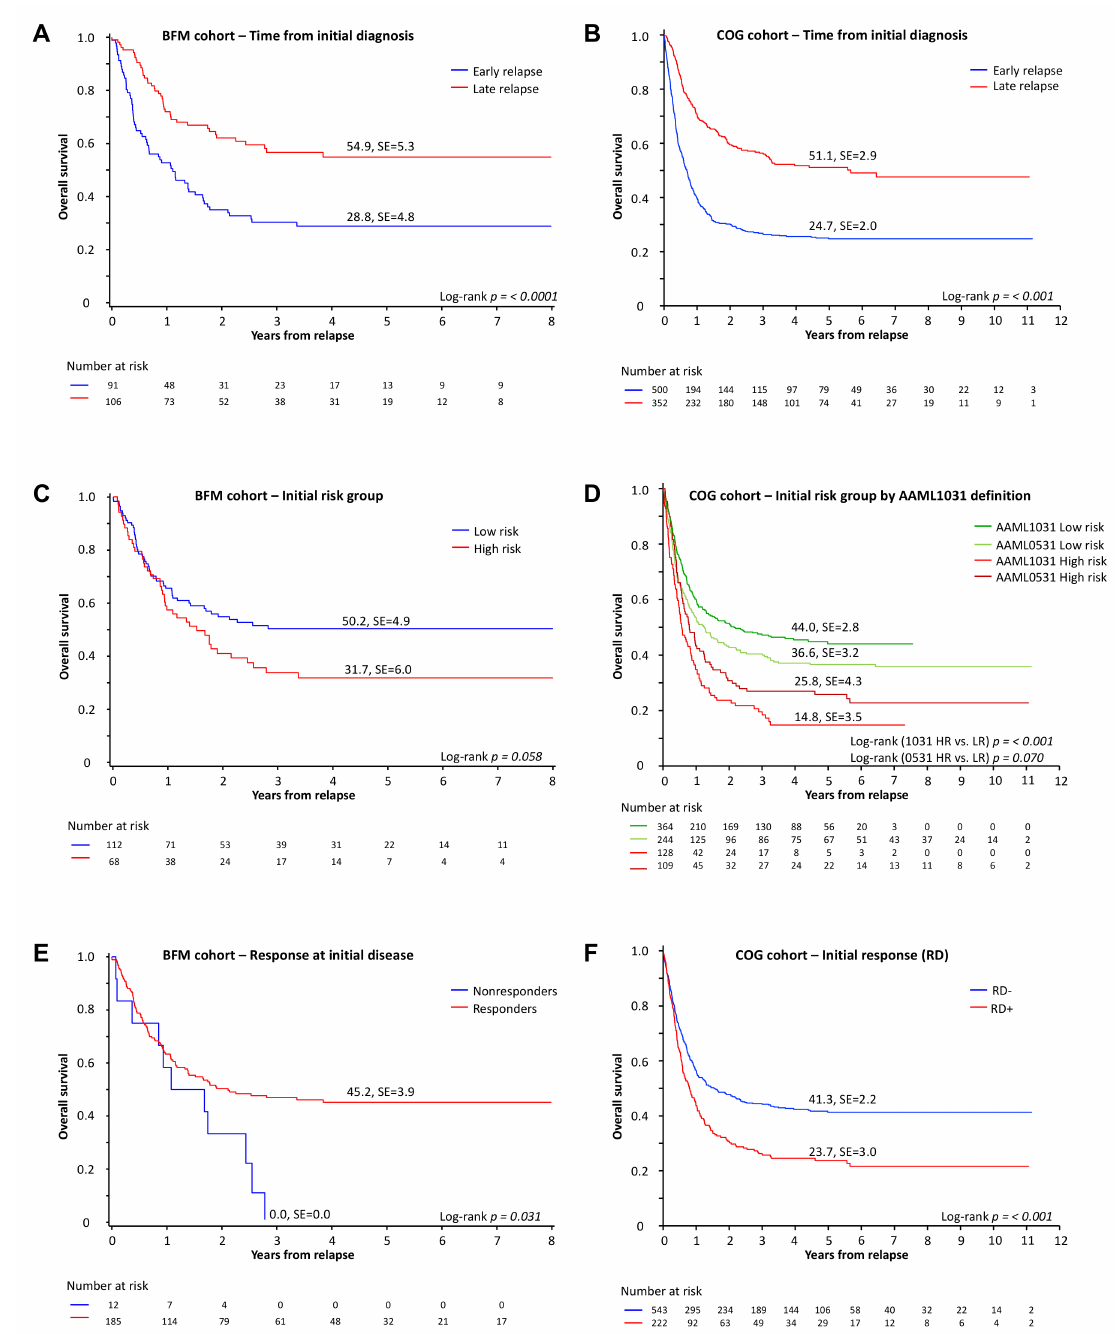
Figure 2. Prognostic factors for post-relapse survival. ( A ) Five-year overall survival of patients with early or late relapse defined as relapse within or after one year of initial diagnosis (BFM). ( B ) Five-year overall survival of patients with early or late relapse (COG). ( C ) Five-year overall survival in patients with first relapse based on the genetic risk profile of the initial diagnosis (BFM). ( D ) Five-year overall survival from relapse for AAML1031 and AAML0531 patients based on a retrospective classification by AAML1031 risk group definition (Table S1). ( E ) Five-year overall survival of patients based on the initial response to induction chemotherapy of the initial disease (BFM). Abbreviations: HR, high-risk. ( F ) Five-year overall survival according to residual disease detection at the end of one cycle of induction following initial diagnosis and treatment